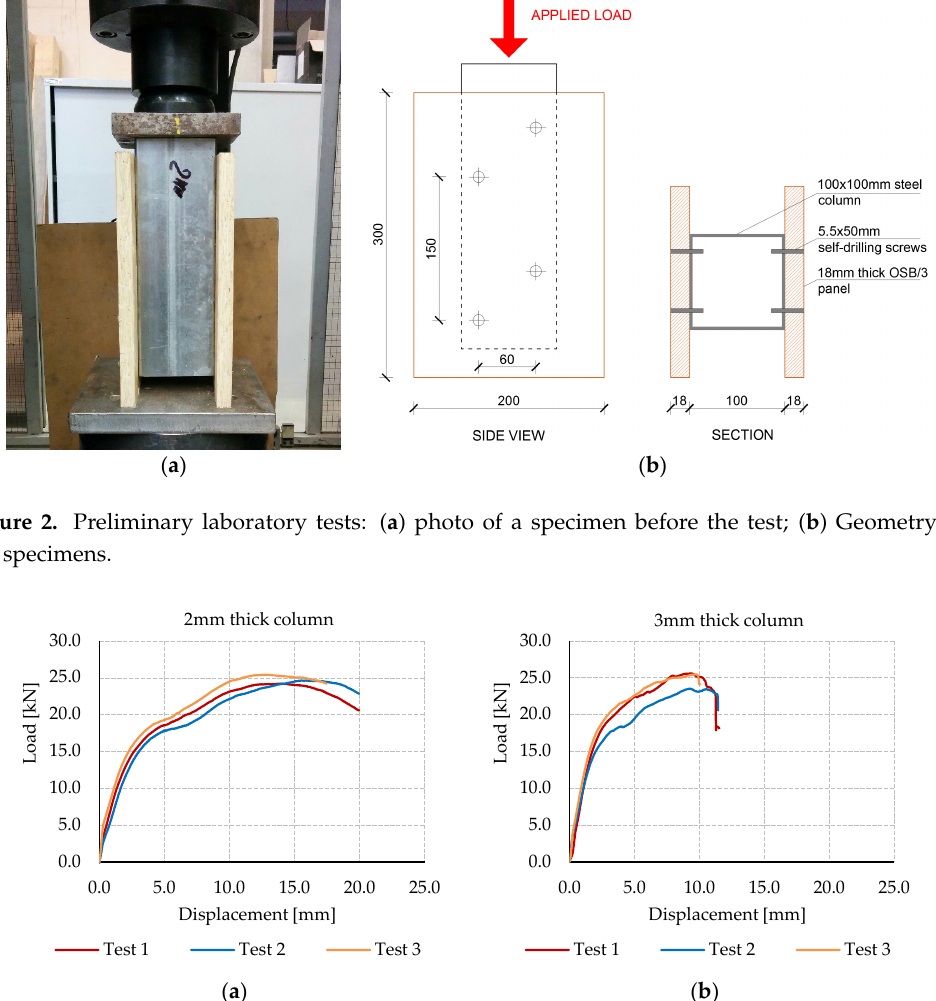
Figure 3. Force ‐ displacement curves for the six tested specimens: ( a ) specimens with 2 mm thick steel column; ( b ) specimens with 3 mm thick steel column.